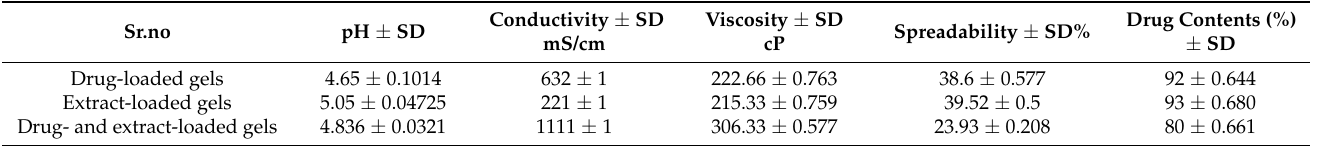
Table 2. Physico-chemical properties of all three topical gels.